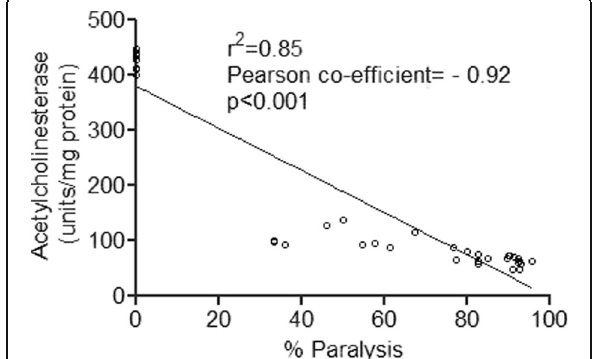
Fig. 4 Correlation between acetylcholinesterase activity and extent of paralysis in Caenorhabditis elegans . Data from control and monocrotophos-treated worms was used for obtaining Pearson correlation